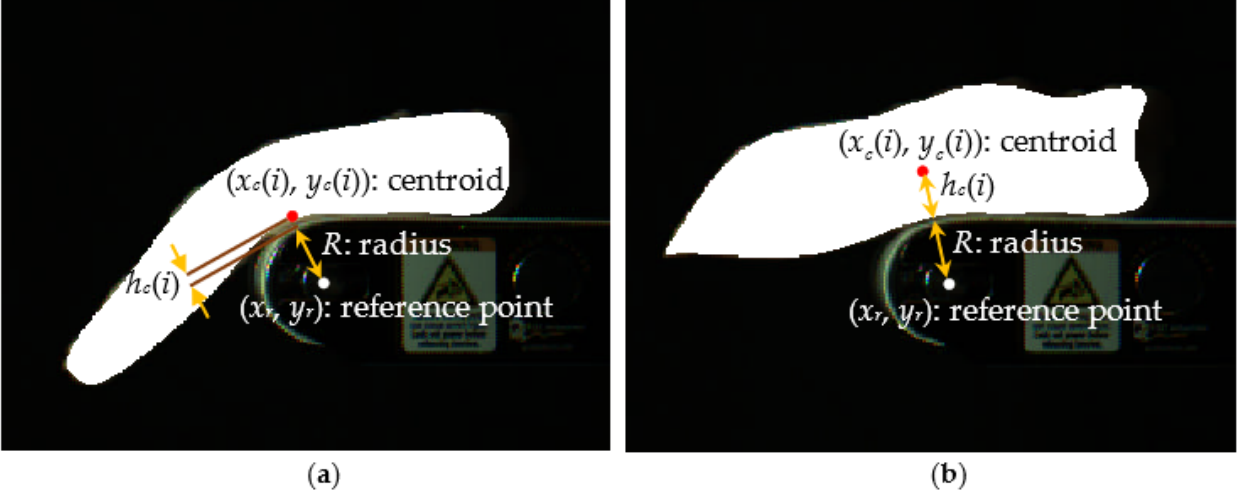
Figure 6. Parameters for distance measure d i = (cid:107) centroid ( i ) − reference point (cid:107) ( a ) normal and ( b ) severe woody breast fillets.